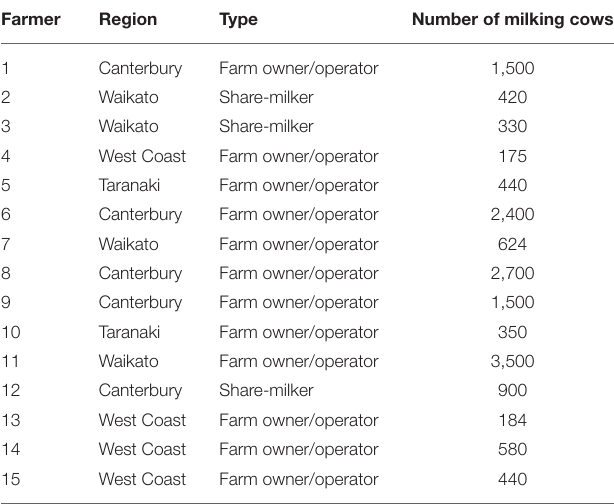
TABLE 1 | Profile of interviewed